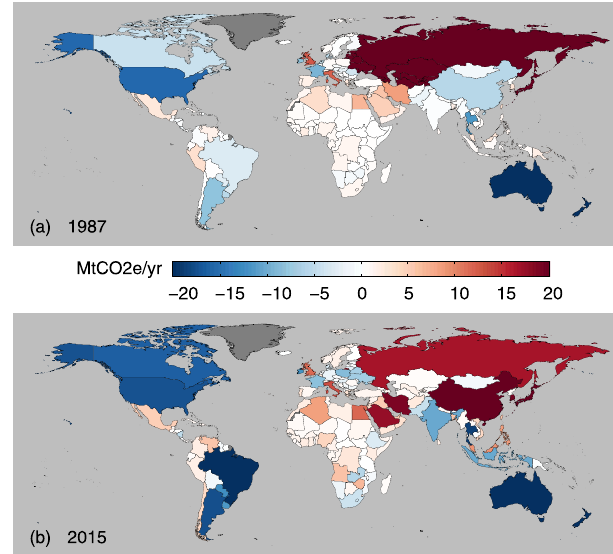
Fig. 2 Differences between trade-adjusted agricultural emissions (TAE) and production-based emissions (PBE). Differences are shown for 1987 (a) and 2015 (b), in total absolute terms.. These differences are calculated by subtracting PBE from TAE, such that the larger the positive difference (darker red), the higher is a country ’ s TAE compared to its PBE (i.e., net importers of agricultural emissions). Likewise, the larger the negative difference (darker blue), the lower is a country ’ s TAE than its PBE (i.e., net exporters of agricultural emissions). Dark grey colours indicate countries with no available data (e.g., Greenland). Per capita differences are shown in Supplementary Fig. East 28 . Speci fi cally, for countries like Bahrain, Kuwait, and the United Arab Emirates, TAEs were at least four times larger than their respective PBEs in 2015. In mainland China, TAE was only around 7.9% higher than PBE in 2015, but this was equivalent to a difference of 51.5 Mt CO 2e /yr – the largest gap in 2015 for countries with larger TAE than PBE in total absolute terms.